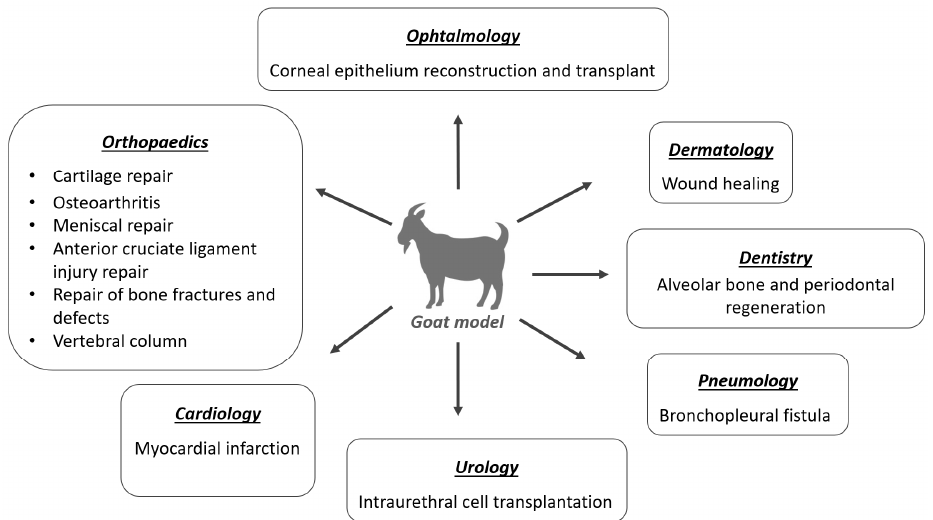
Figure 1. Clinical applications of MSCs studied in the goat model, according to medical